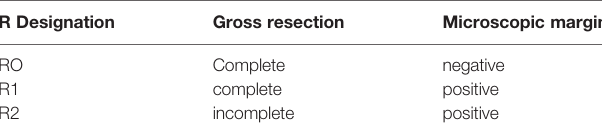
TABLE 1 | Quality of surgery: